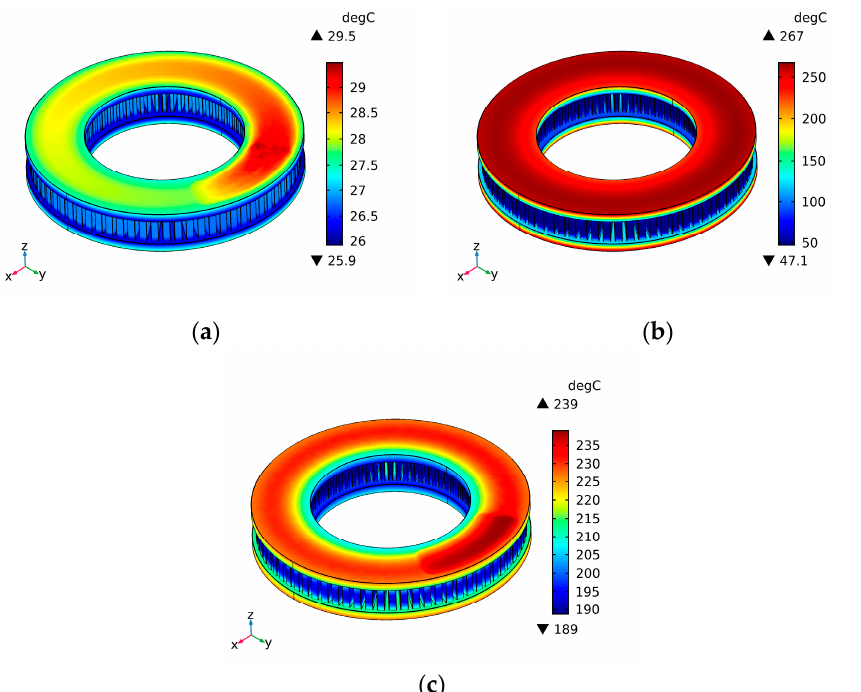
Figure 8. Surface temperature clouds of ventilated discs at different braking moments. ( a ) Braking 0.05 s; ( b ) braking 35 s; ( c ) braking 70 s.